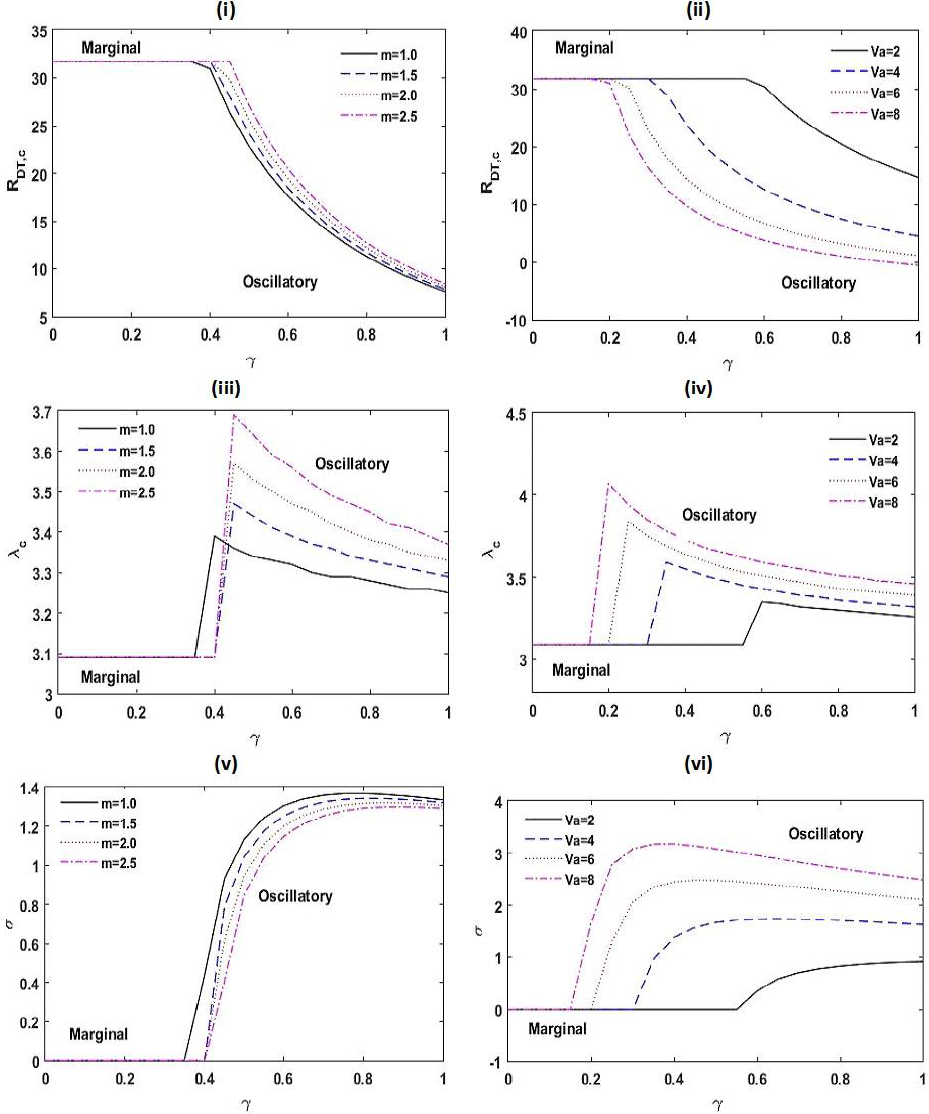
R ,  , and  with  for different values of m and Va Figure 7. Variation in R DT,c , λ c , and σ with γ for different values of m and Va at Le = 2, m = 1.5, Figure 7. Variation in DT,c c A = 1, R DS = 3, S N = 0.5, K RN = 0.5, and Va = at